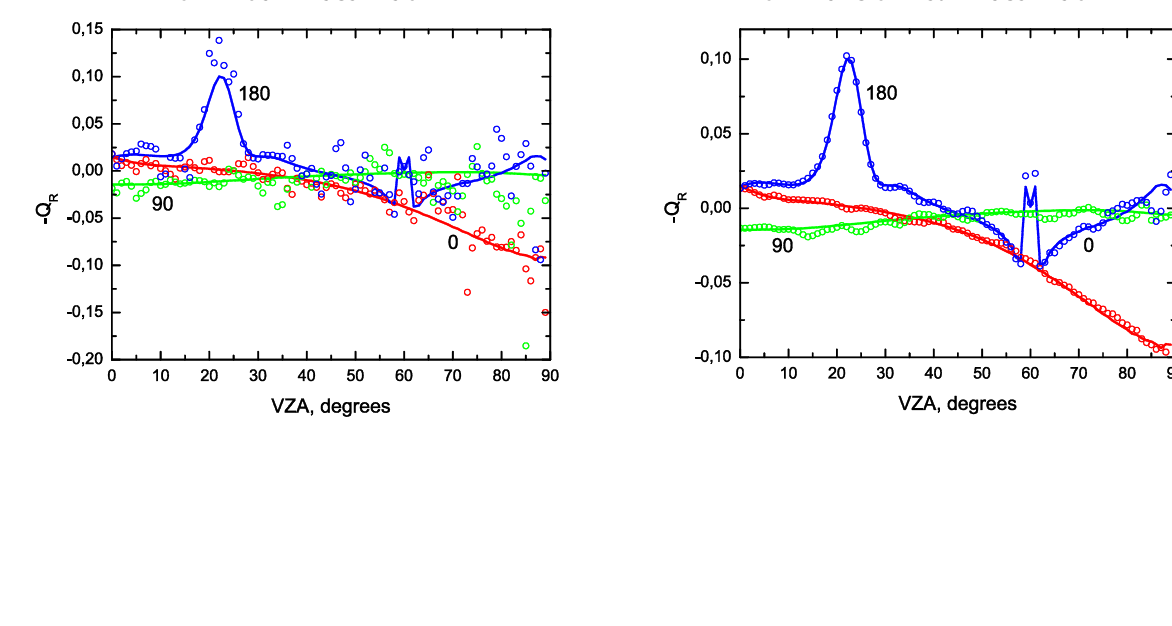
Figure 7. The normalized -Q-parameter of the Stokes vector (line—SCIATRAN, circles—FLBLM) in reflected light for cloud case. The number of photons is 10 5 . Relative azimuths are 0°, 90°, and 180°. Azimuths counter clock-wise. For Initial Phase Matrix For Transformed Phase